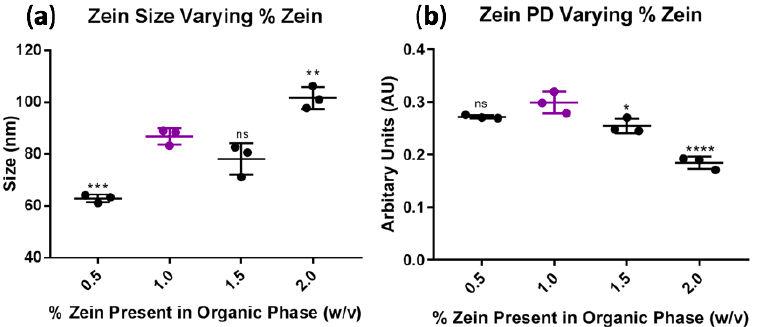
Figure 4. Impact of the percentage of Zein present on Zein nanoparticles (NPs): ( a ) diameter; ( b ) polydispersity (PD).